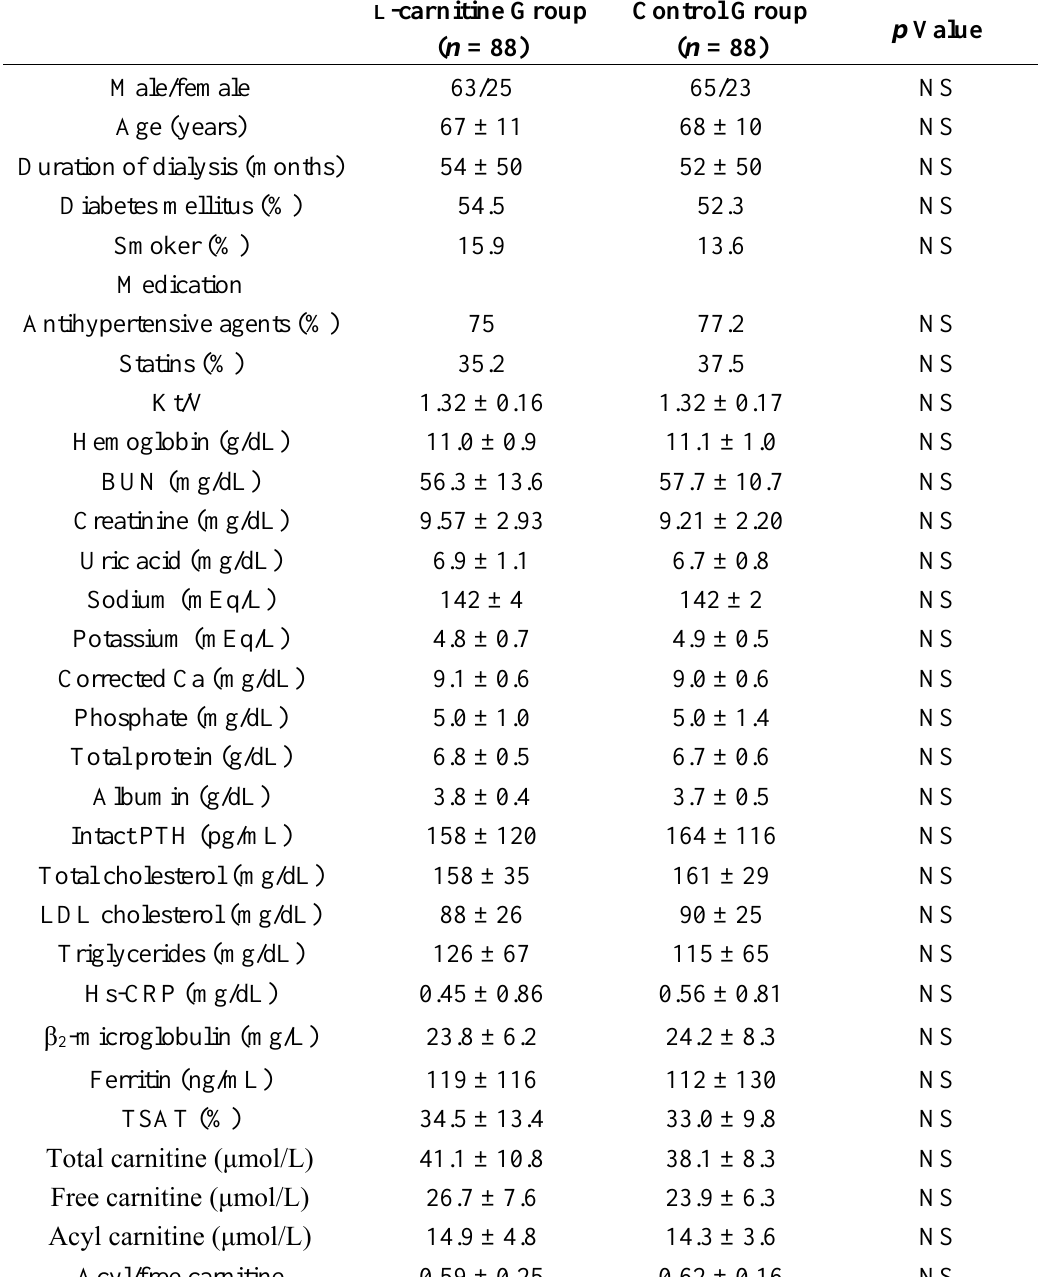
Table 1. Baseline demographic and clinical